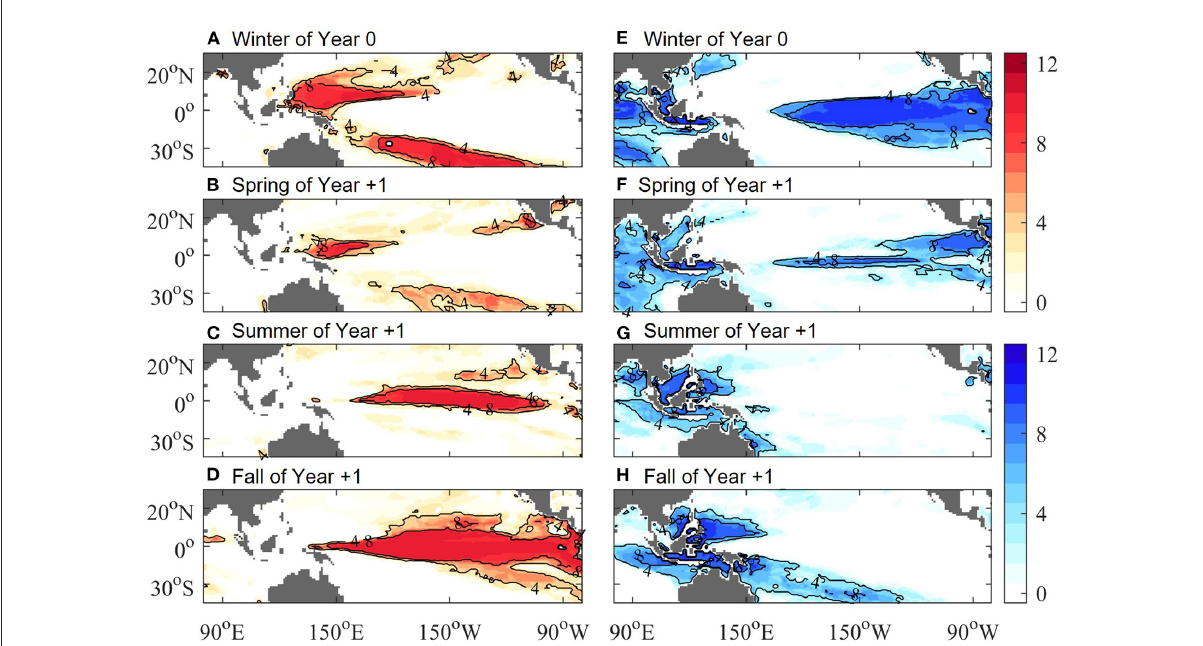
FIGURE12 Numbers of ensemble members of the CNRM-CM5 model with significant positive correlations between the STIO SSTA in fall and the tropical Indo-Pacific Oceans SSTA in (A) winter of Year + 0, (B) spring of Year + 1, (C) summer of Year + 1, and (D) fall of Year + 1. (E–H) are same as (A–D) , but for significant negative correlations.